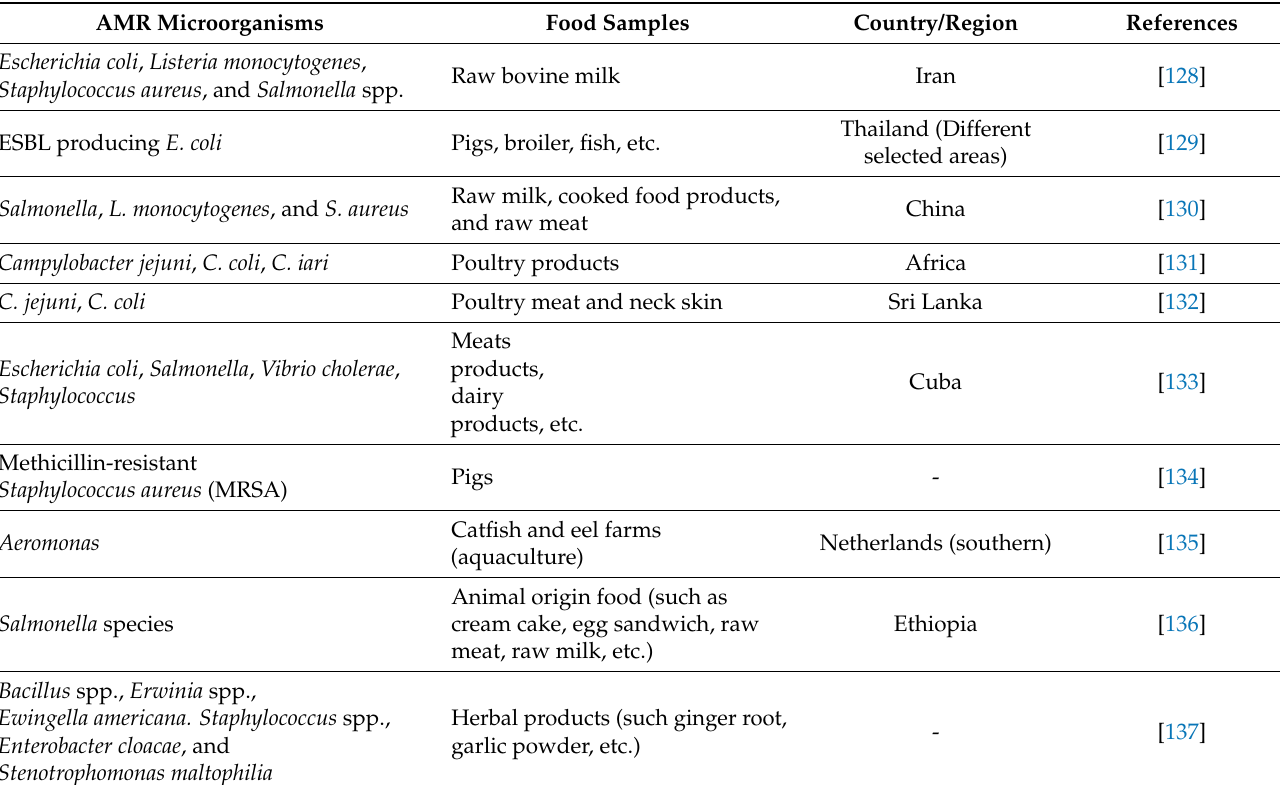
Table 1. Different AMR bacteria in various food samples (plant and animal